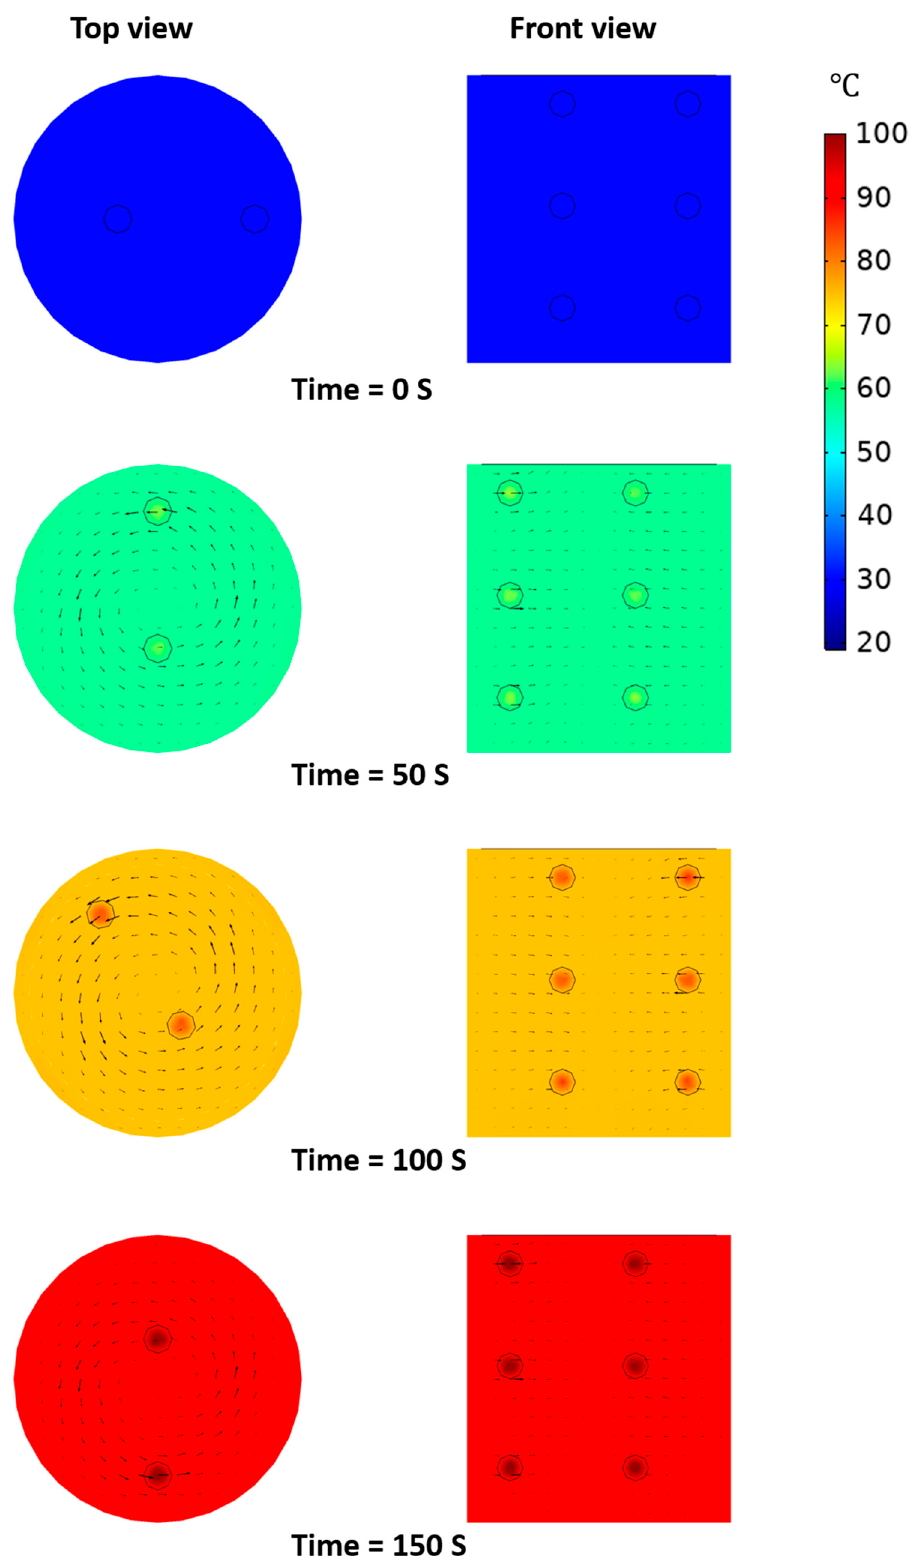
Figure 10. Simulated heating pattern of model food under OH with agitation.